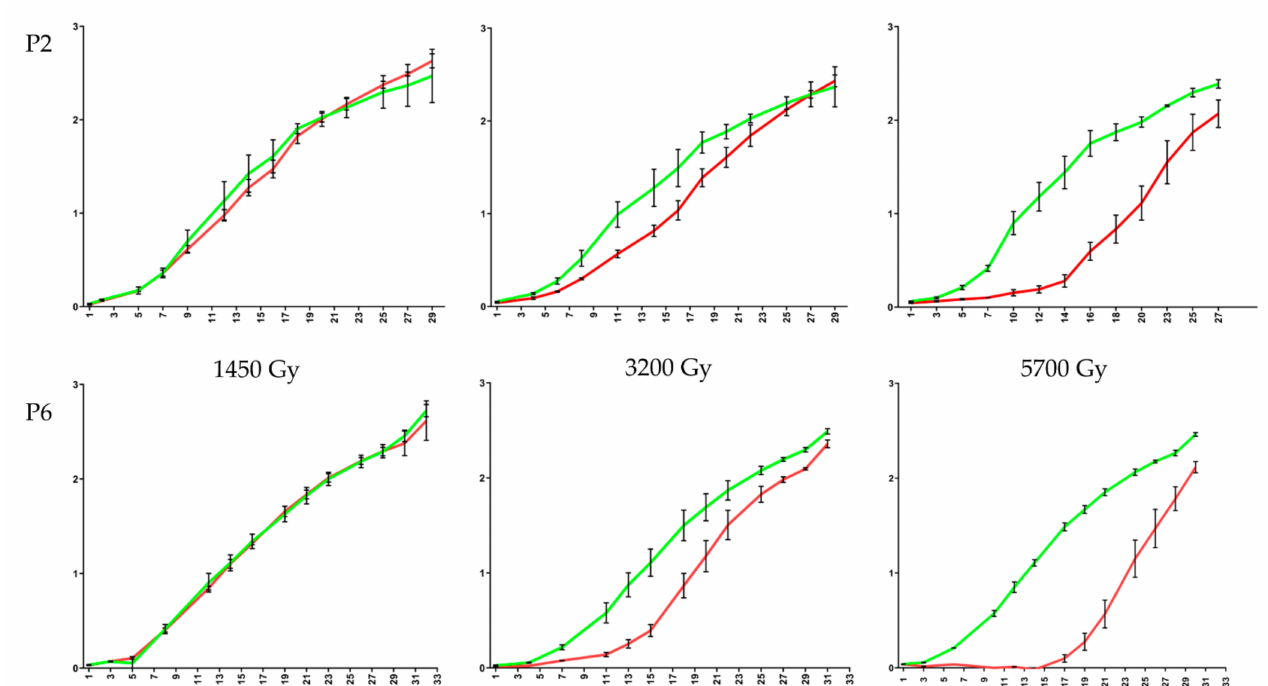
Figure 2. Growth curves of L. indica PCC 8005 subtypes P2 and P6 plotted as optical density at 750 nm (OD 750 ) ( y -axis) versus time in days ( x -axis). Red curves represent gamma-irradiated cultures while green curves represent non-irradiated control cultures. Samples for post-irradiation outgrowth were taken in triplicate at three timepoints amounting to cumulative doses of 1450, 3200, and 5700 Gy. At the same time points triplicate samples were taken from non-irradiated control cultures. Data represent the mean of three independent biological replicates, and error bars present the standard error of the mean (SEM).